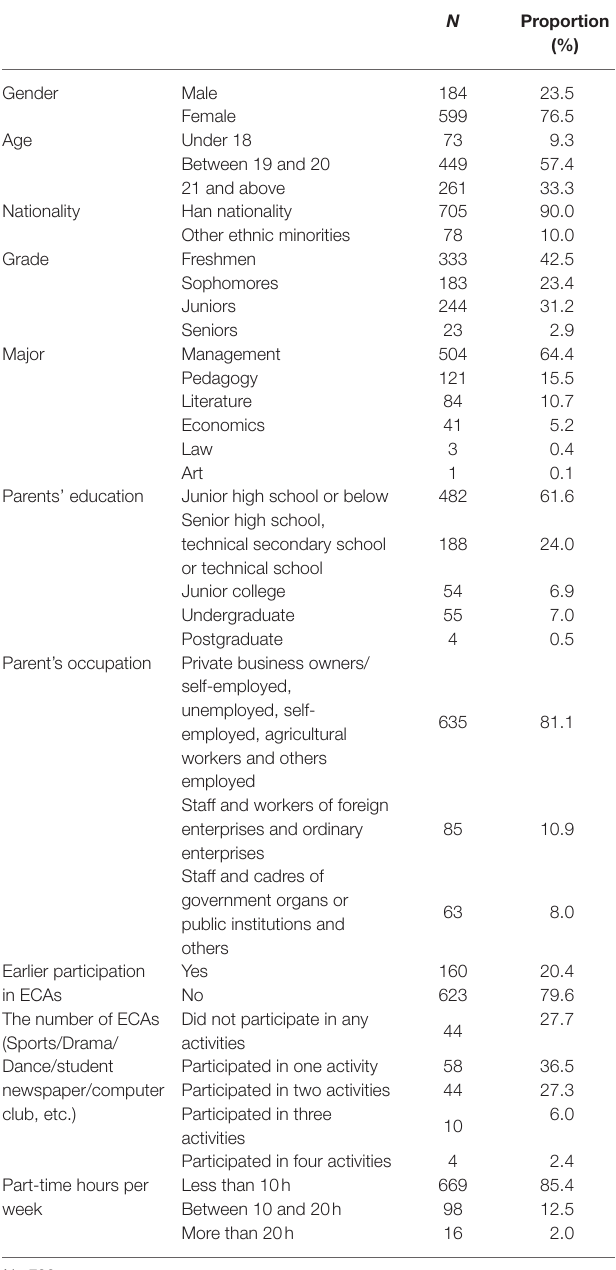
TABLE 1 | Demographic information of